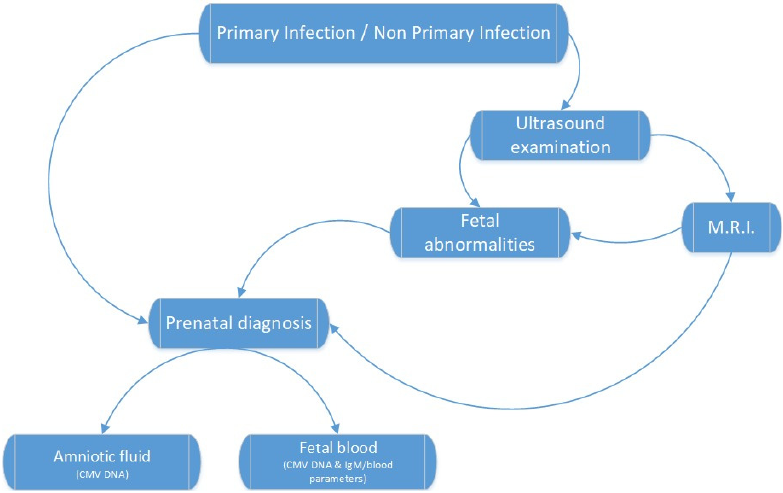
Figure 2. Fetal diagnosis of CMV infection [4].